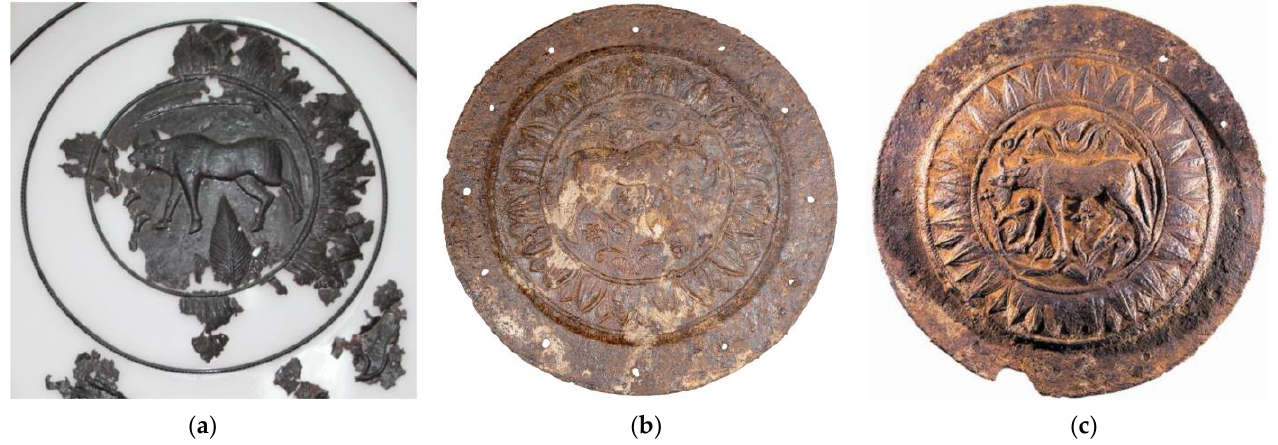
Figure 13. Dimensions of the three registers, as well as the width of the outer border. ( a ) Fragmented aurochs’ disk ; ( b ) Repatriated aurochs’ disk ; ( c ) Black market listed aurochs’ disk .